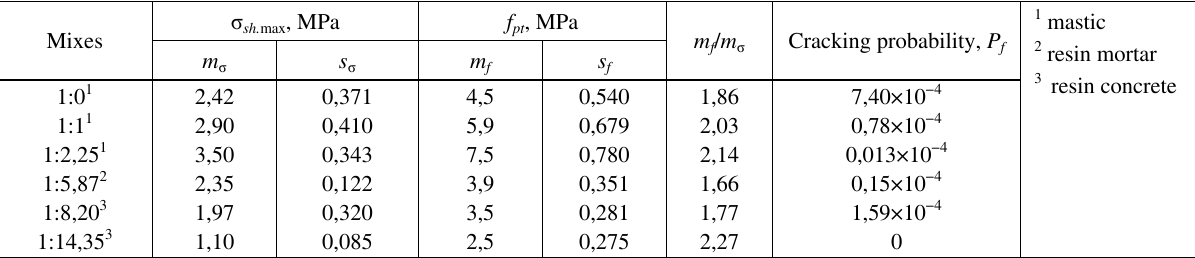
Table 4 . Maximum shrinkage stresses for various polymer